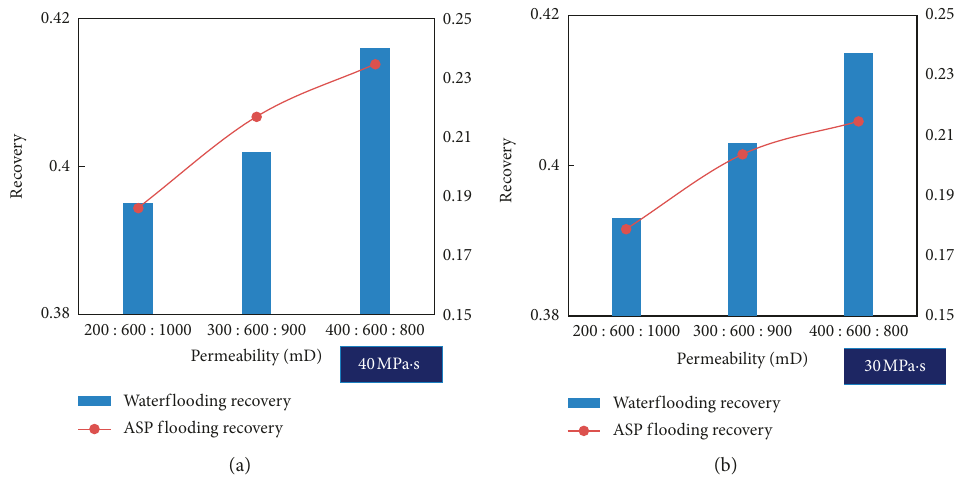
Figure 11: Oil recovery comparison. (a) Oil recovery with viscosity of 40 MPa · s. (b) Oil recovery with viscosity of 30MPa · s.